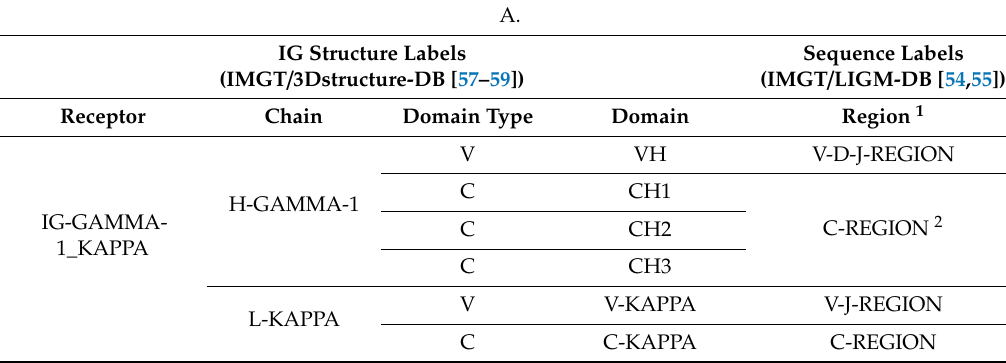
Table 1 . Immunoglobulin (IG) receptor, chain and domain structure labels and correspondence with sequence labels [34]. IMGT standardized labels are in capital letters [34,35]. They are shown for two examples of IG: A . Homo sapiens IgG1 ‐ kappa, B . Homo sapiens IgM ‐ lambda.